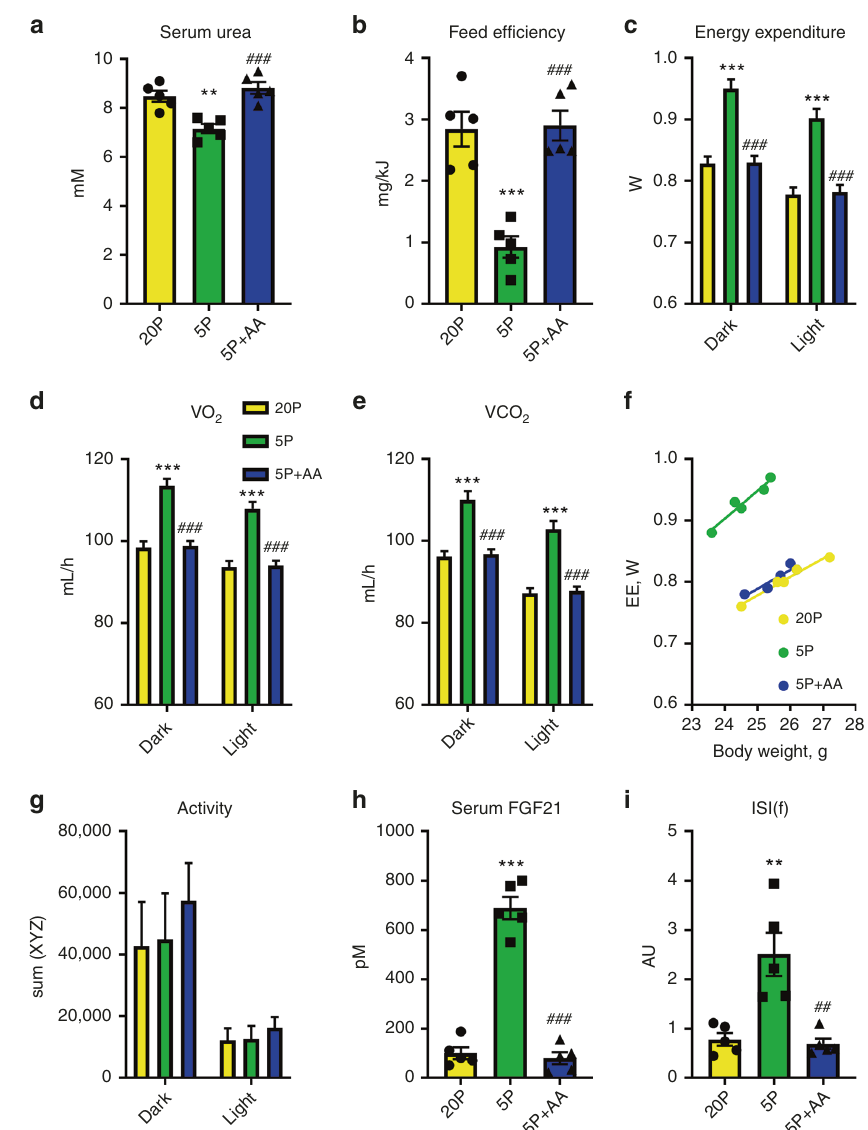
Fig. 1 Dietary amino acids are required for the systemic metabolic effects of dietary protein dilution. a Serum urea levels of mice in response to a 3- week treatment with diets containing 20% energy from protein (20P), 5% energy from protein (5P), and 5% energy from protein and 15% energy from amino acids to match that of 20P. Data are mean and SEM; n = 5 individual mice per group. Data were analysed by one-way ANOVA with Holm – Sidak post-hoc tests. Different than 20P: * P < 0.05, ** P < 0.01, *** P < 0.001. Different than 5P: # P < 0.05, ## P < 0.01, ### P < 0.001. b Feed ef fi ciency of mice as